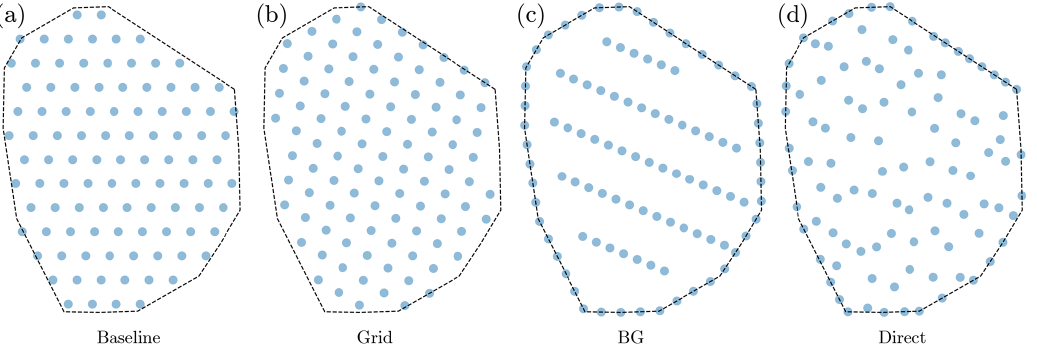
Figure 8. Example optimal layouts achieved with each parameterization method. These are 100-turbine layouts, with an average turbine spacing of 4 rotor diameters and the Princess Amalia wind farm boundary. They were optimized with the wind rose from North Island, California. (a) The baseline grid to which other methods were compared in Sect. 5.1. (b) An example optimized grid layout. (c) An example optimized boundary-grid layout. (d) An example layout that was optimized